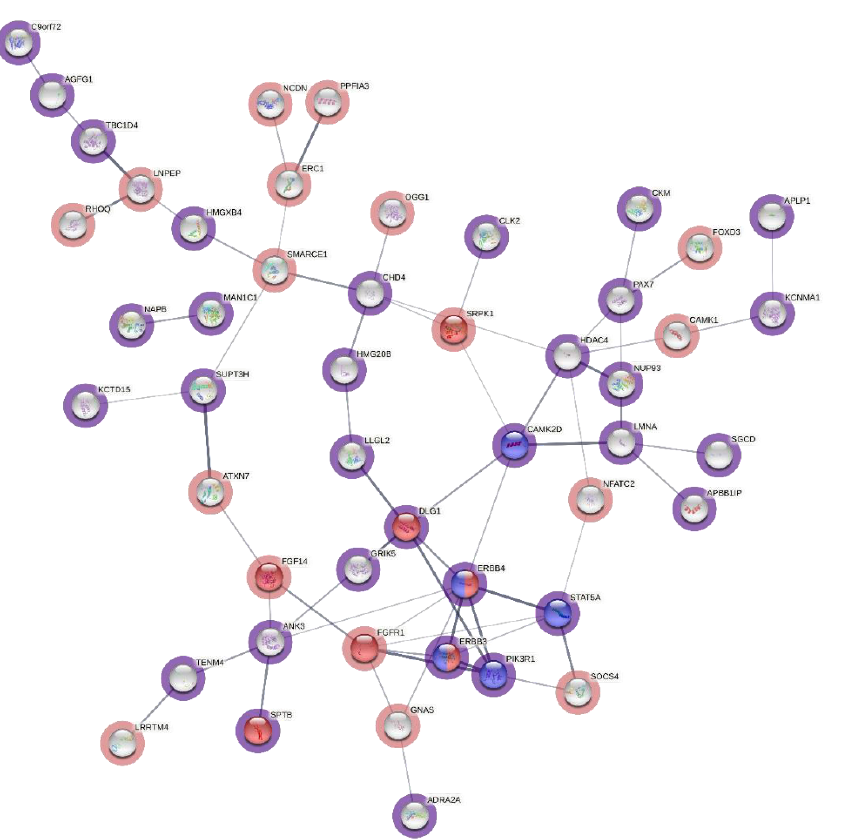
Figure 4. Protein interaction network of genes with 3′ UTR variants generated by STRING. No path- way enrichment was found here. Due to the lack of pathway detection, the color of the nodes was randomly selected by the software and serves only for differentiation purposes.